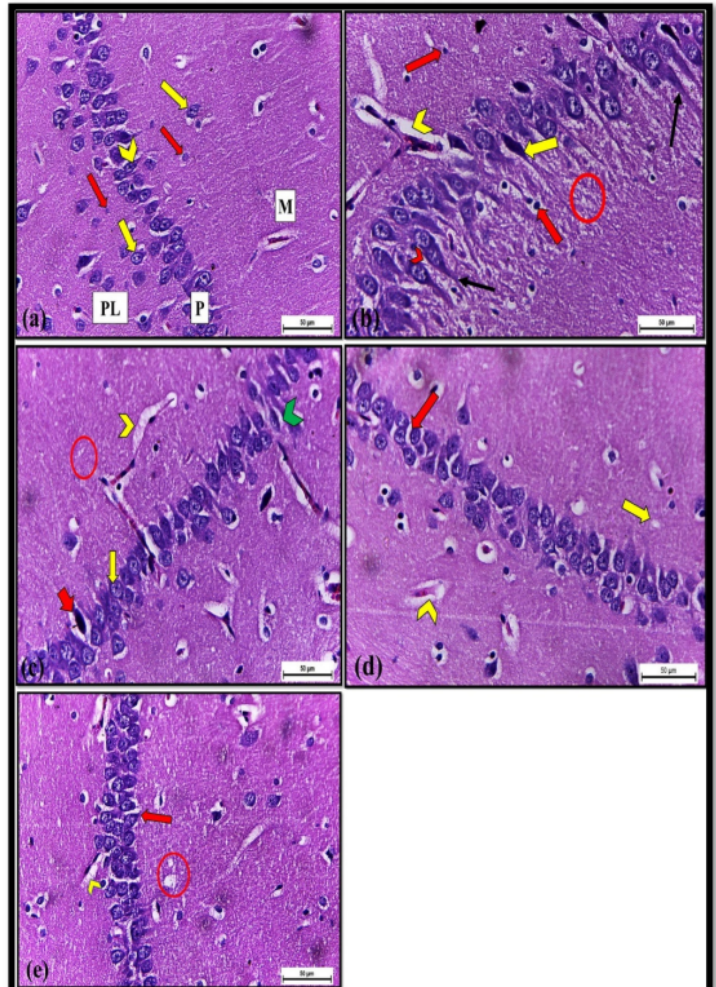
Figure 3. Brain tissue sections of albino rats from the hippocampal region H and E × 400. ( a ) Control rats (Group I) showed normal molecular layer (M), pyramidal cell layer (P), polymorphic cell layer (PL). The molecular layer contained neuronal cells (yellow arrow) and neuroglia cells (red arrow). The pyramidal layer consisted of triangular cells (chevron), and the polymorphic cell layer contained neuronal cells (yellow arrow) and neuroglia (red arrow). ( b ) Dox-exposed rats (Group II) revealed histopathological changes such as neuropil vacuolation (circle), pyknotic neuroglia cells (red arrow), degenerated, shrunken and hyperchromatic pyramidal cell (yellow arrow). A wide perivascular space with congested blood capillary (yellow chevron) was observed. Additionally, some pyramidal cells with neurofibrillary tangles (line arrow) and pericellular space (red chevron). ( c ) Dox+ C100 treated rats (Group III) revealed partial recovery compared to group II in the form of diminishing of neuropil vacuolation (circle), perivascular space (yellow chevron), and perineuronal space (green chevron). Pyramidal cells restored their triangular shape with a vesicular nucleus (yellow arrow), but few pyramidal cells appeared degenerated (red arrow). ( d ) Dox+ C300 (Group IV) and ( e ) Dox+ C500 (Group V) treated rats showed regeneration signs same to group III in the form of nearly normal pyramidal cells (red arrow), few neuropil vacuolations (yellow arrow and circle), and reduced perivascular space (yellow